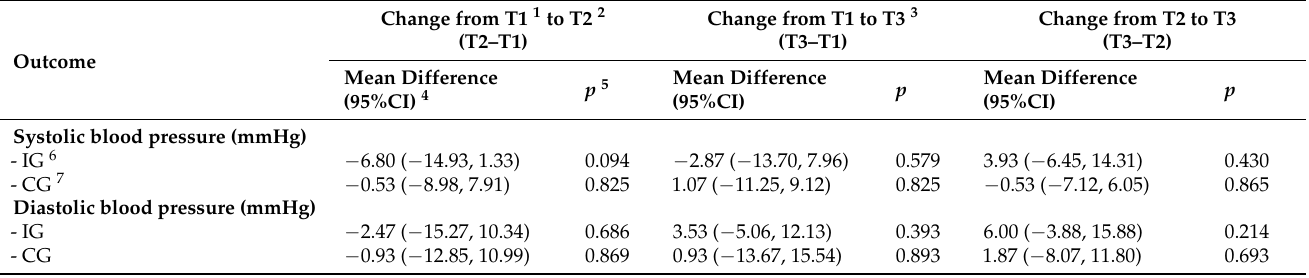
Table 7. Within-group differences in blood